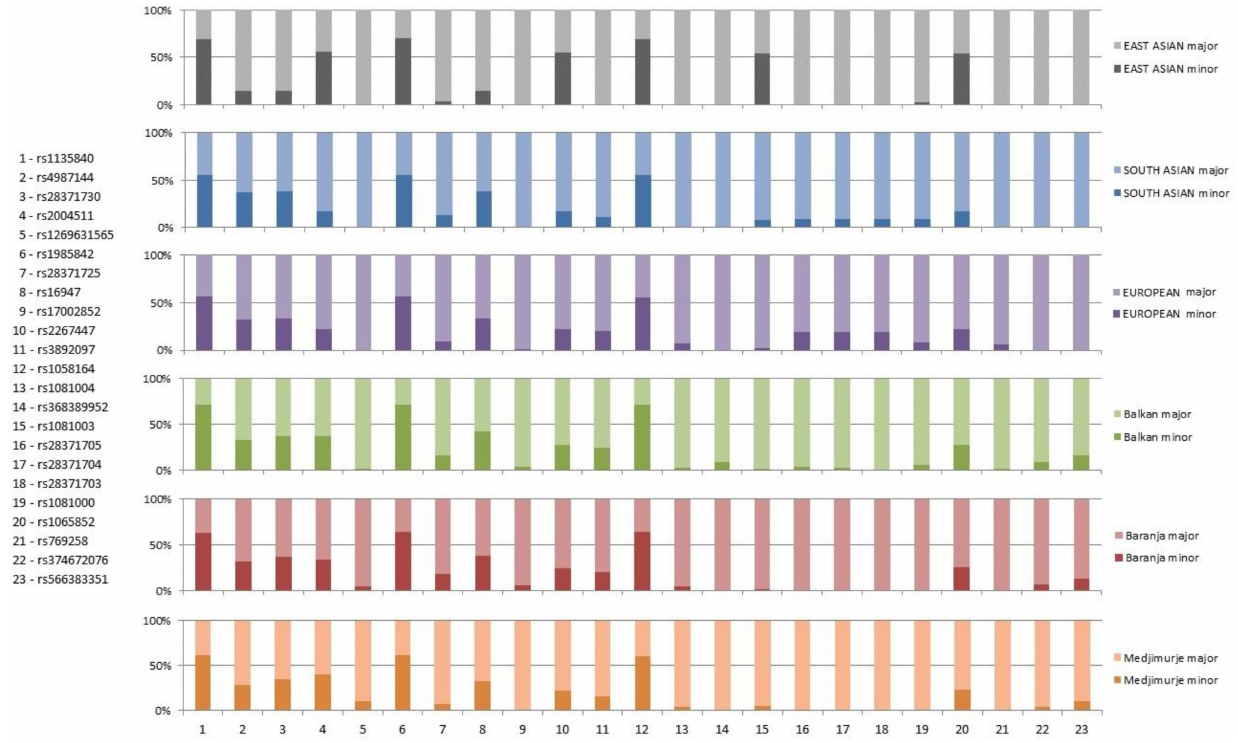
Figure 2. Allele frequencies of CYP2D6 SNPs in East Asian, South Asian, and European (non-Finnish) populations (as reported in gnomAD database, version 3.1.1) and in three Croatian Roma populations. A total of 93 CYP2D6 haplotypes were reconstructed from polymorphic SNPs, as